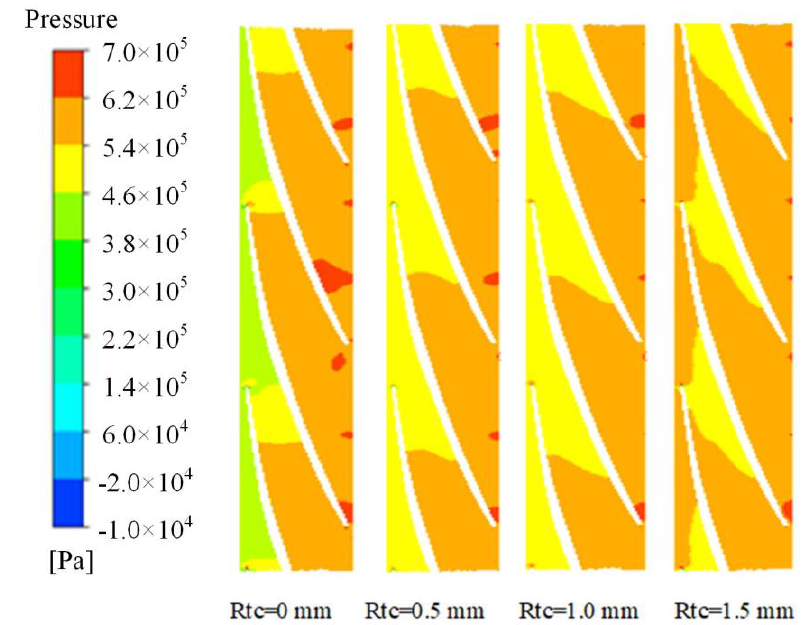
Figure 10. Pressure on the radial coefficient r * = 0.9.